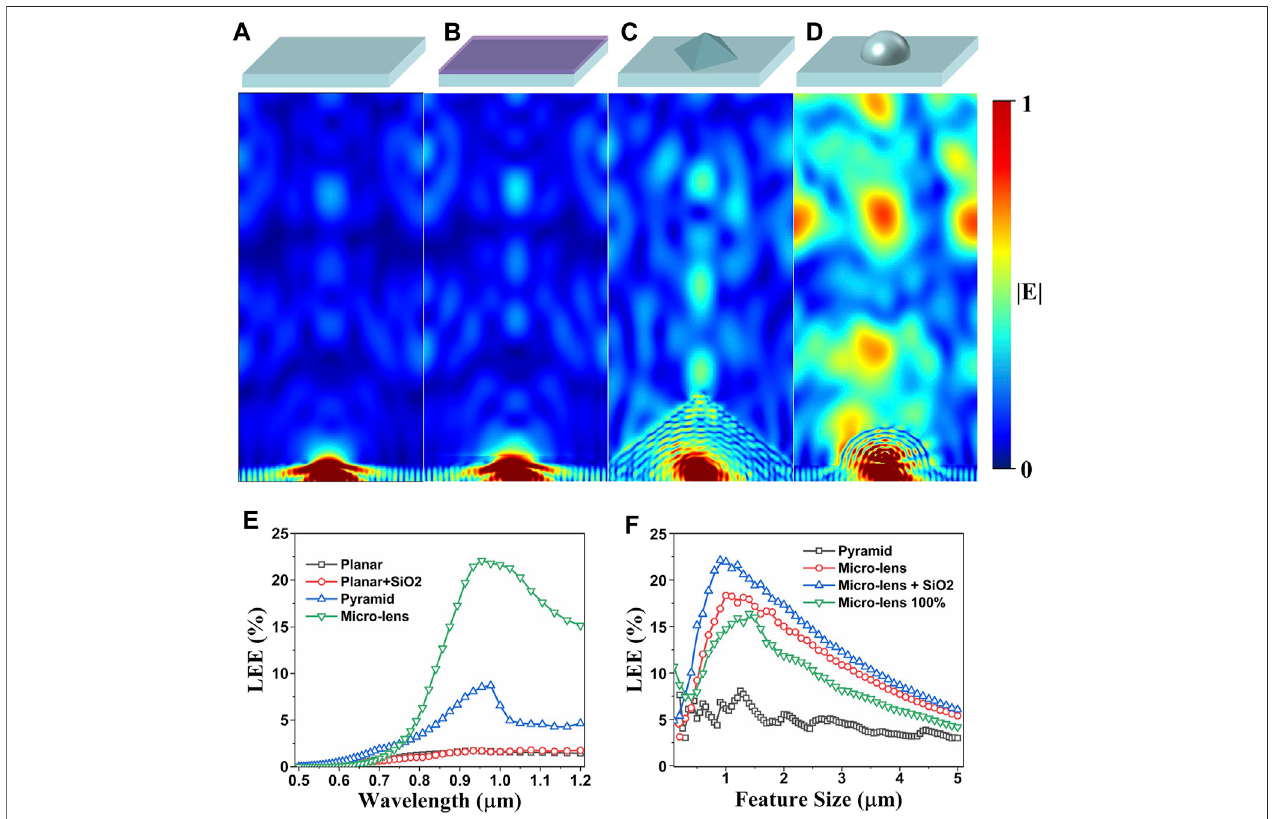
FIGURE5| TheschematicdiagramoftheLEDdevicewithdifferentgeometries,alsoshowingthecorrespondingopticaldistributionforthesamedipolesourcewith acertainwavelengthof870 nm. (A) Planarstructure. (B) PlanarstructurewithSiO 2 ARcoating. (C) Micro-pyramidstructure. (D) Micro-lensstructure. (E) Thecalculated LEE as a function of the emitting wavelength for the devices with different geometries. (F) Optimization results for the pyramid and micro-lens structure. The feature size corresponds to the bottom side length of the pyramid or the radius of the hemi-sphere-like micro-lens.